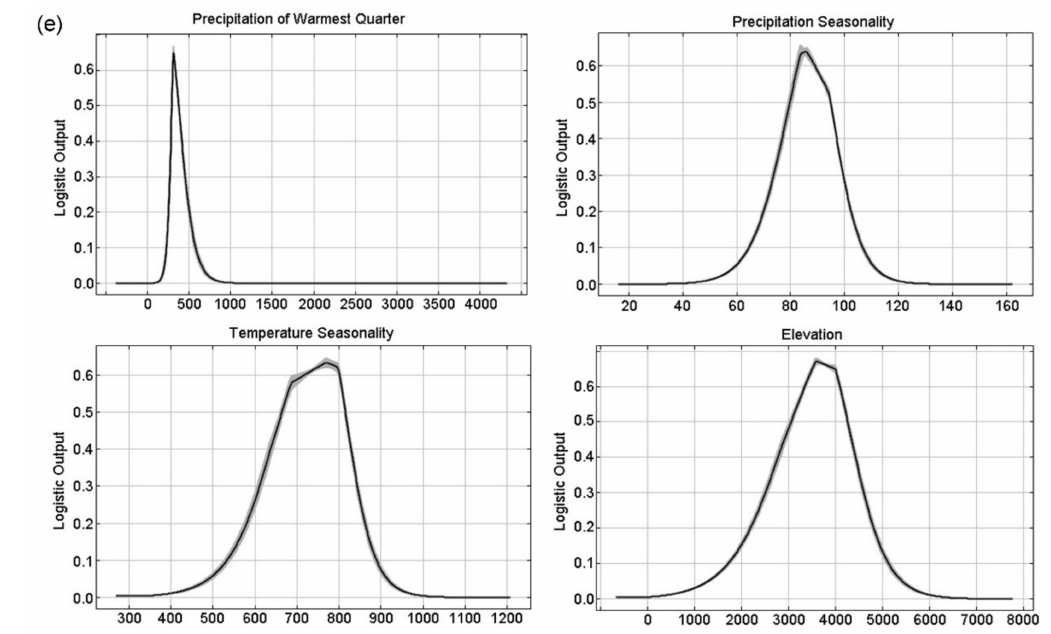
Figure 4. Relationships between key predictor variables and probability of presence of ( a ) Meconopsis species, ( b ) M. integrifolia , ( c ) M. horridula , ( d ) M. racemose , and ( e ) M. punicea . Table 3. Relative contribution (%) of environmental variables to the MaxEnt model output for